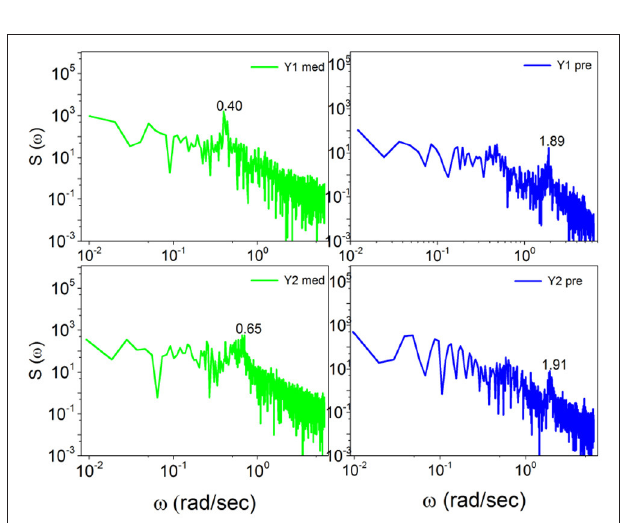
FIGURE 6 | The power spectra S ( ω ) of Kundalini Yoga meditators (Y1, Y2) before, on the right, and during meditation, on the left. Notice the spectra for Y1 and Y2 meditators consist of significant bumps both before and during meditation. The bump shifts for Y1 meditator from ω = 1.89( rad / s ) before meditation to ω = 0.4( rad / s ) during meditation. Similarly the bump shifts for Y2 meditator from ω = 1.91( rad / s ) before meditation to ω = 0.65( rad / s ) during